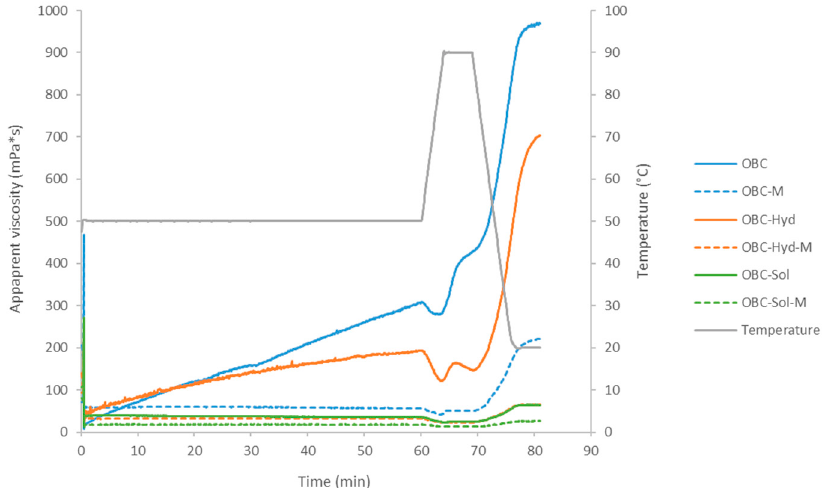
Figure 4. Viscosity (mPa·s) of the OBC samples in suspension as a function of time (min) and temperature ( ◦ C). OBC: Oat bran concentrate; OBC-Hyd: OBC hydrolyzed with β -glucanase; OBC-Sol: water-soluble fraction from OBC after hydrolysis with β -glucanase; OBC-M: OBC microfluidized; OBC-Hyd-M: OBC-Hyd microfluidized; OBC-Sol-M: OBC-Sol microfluidized.